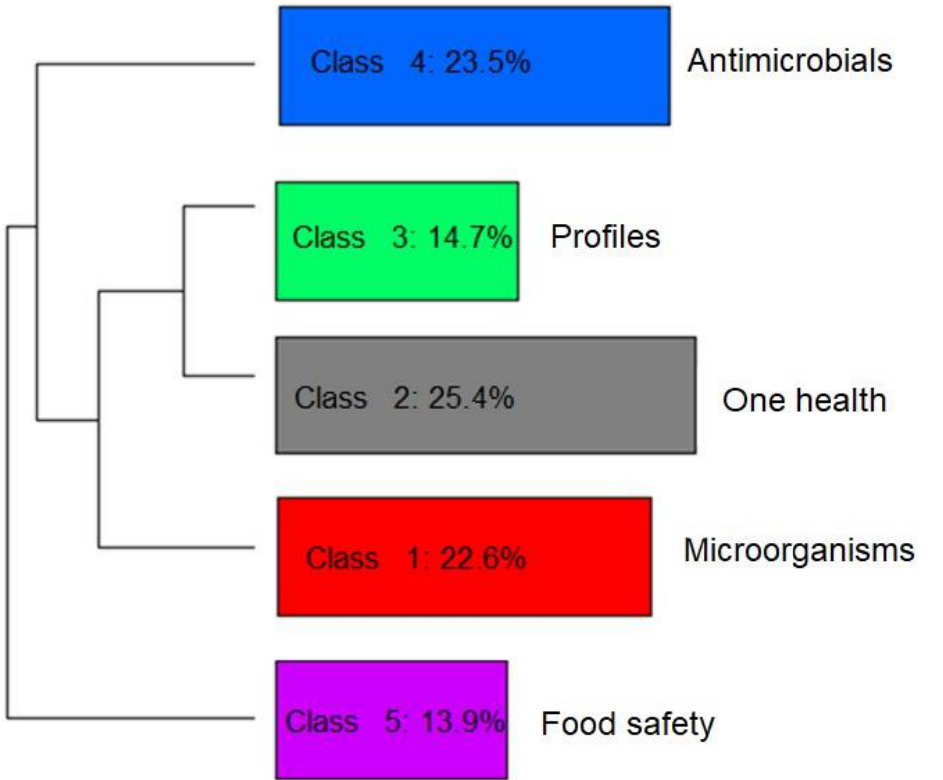
Figure 5. Hierarchical representation and classification of the five groups formed by dividing the textual corpus of the abstracts of the articles selected by the integrative review on microbiological diagnoses of Salmonella spp. in aquaculture between 2000 and 2020, according to the similarity of terms.